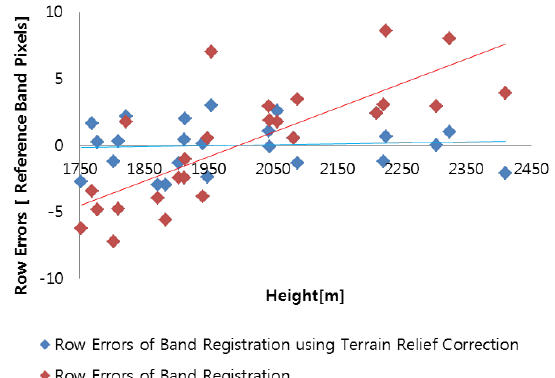
Figure 7. Row Errors depending on Height of band registration using terrain correction and without it